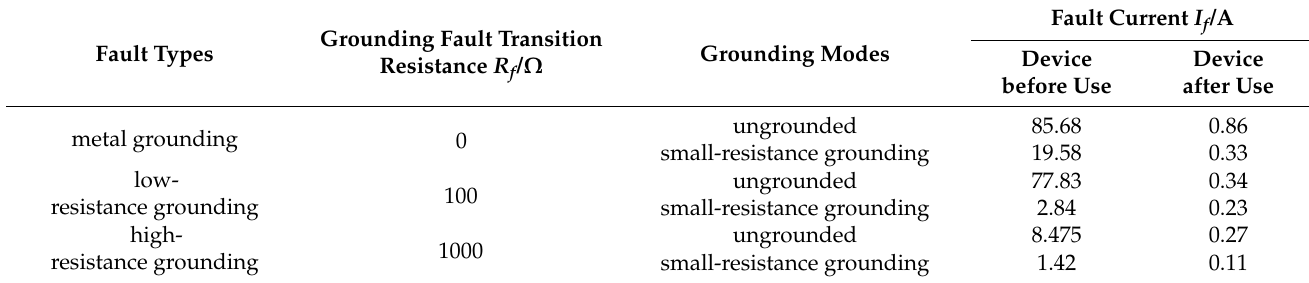
Table 2. Comparison of the fault current before and after flexible grounding.